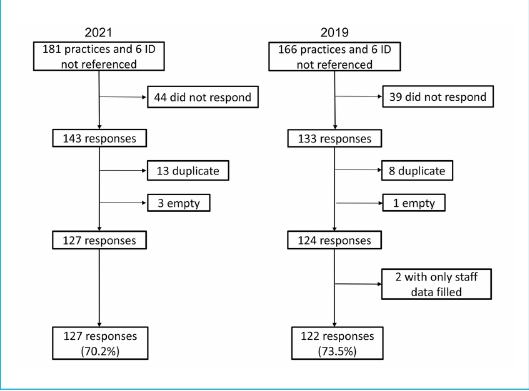
Figure 1: Flow chart showing the response rate of practices invit- ed to participate in the surveys on infection prevention and control measures in 2021 and 2019. ID: identifier.